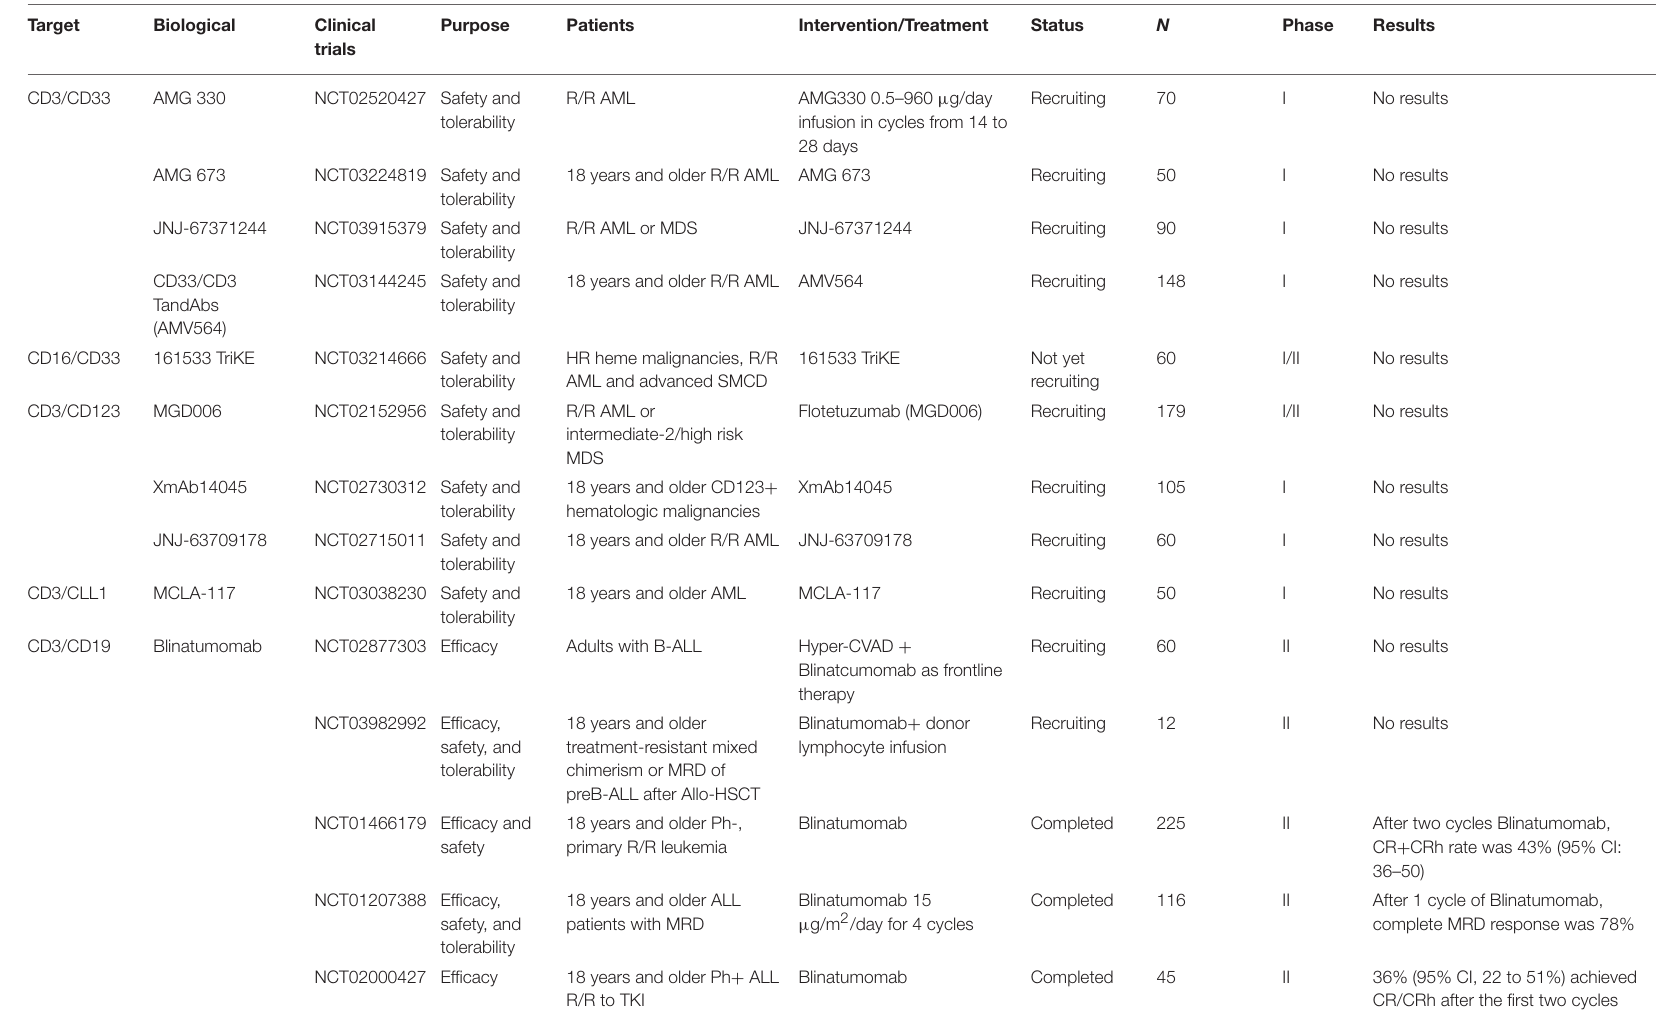
TABLE 3 | Selected completed or ongoing trials of bispecific or Tri-Specific T cell or killer Engagers antibody directed therapy for AML and ALL.